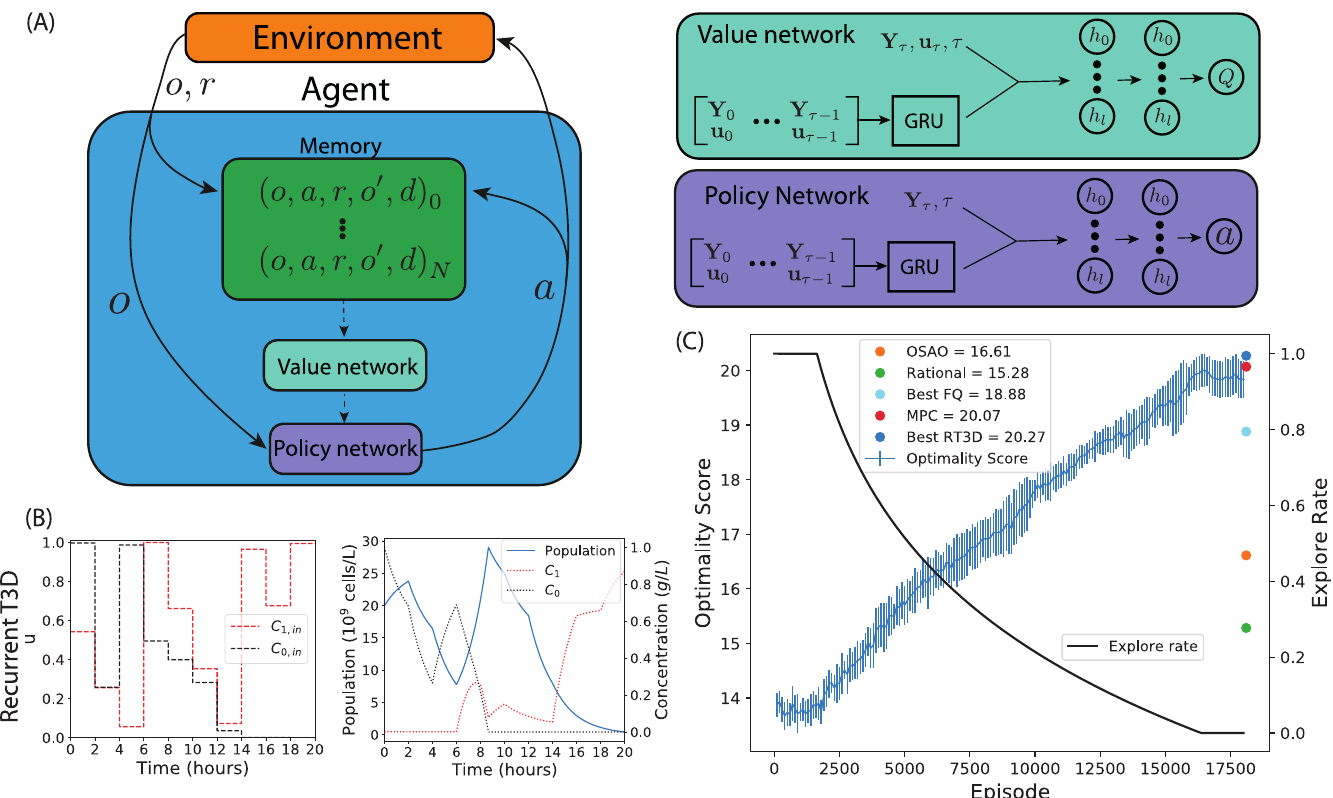
Fig 3. The recurrent T3D algorithm. (A) Structure of the RT3D agent (left) and the artificial neural networks used to approximate the value function (top-right) and policy (bottom-right). (B) Control inputs chosen by the best performing Recurrent T3D instance and the corresponding system trajectory. (C) Average training progress and shared explore rate of ten Recurrent T3D agents over 17500 episodes and the scores (far-right) of the MPC, OSAO and rational design. Error bars indicate one standard